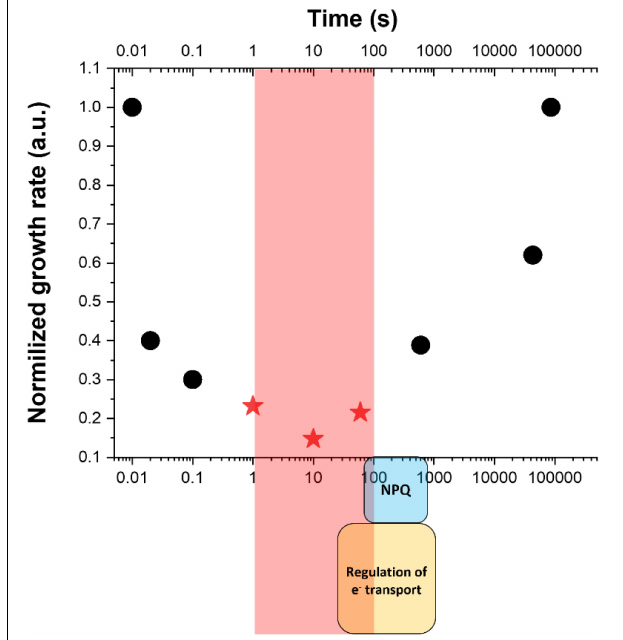
FIGURE 2 | Impact of light fluctuations on microalgae growth. Data indicate the growth rate of Nannochloropsis gaditana as a function of light fluctuations with different frequencies, taking that the same optimal amount of photons has been provided to the different cultures [150 µ moles of photons m − 2 s − 1 (Sforza et al., 2012)]. Red stars indicate a drop ≈ 85% of biomass productivity and correspond to frequencies in the 1–100 s range (highlighted by a red square) where short-term mechanisms for the regulation of photosynthesis [i.e., regulation of electron (e − ) transport and NPQ, indicted by a yellow and light blue square at the bottom] are not fully activated. Data are re-elaborated from Sforza et al. (2012) and Bellan et al.